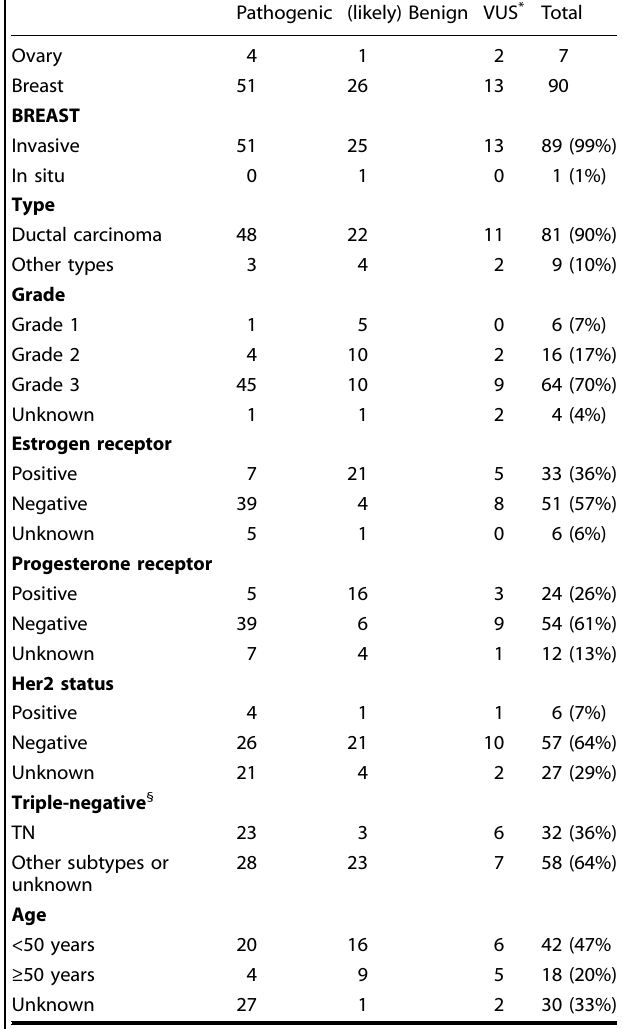
Table 1. Number of breast and ovarian samples analyzed for each variant category. Clinical and pathological data of the breast carcinoma